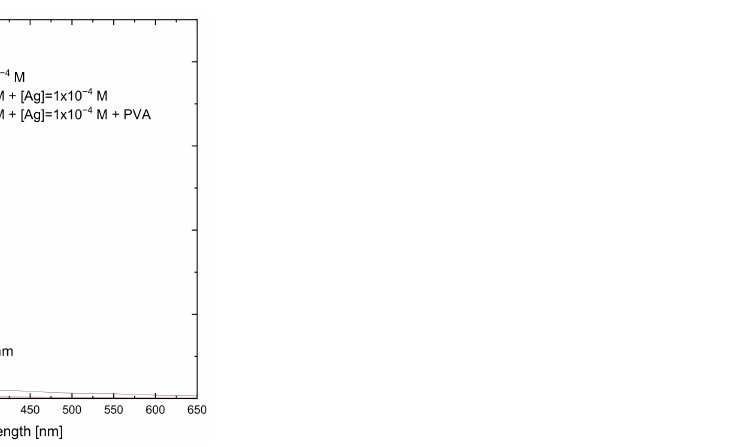
Figure 11. UV–Vis spectra of solutions of synthesized bismuth–silver–rhenium nanoparticles in the pres- ence and absence of a stabilizer (PVA), at a silver concentration of 1 × 10 − 4 M and bismuth and rhenium concentrations in the range of 1 × 10 − 3 M and 1 × 10 − 4 M.